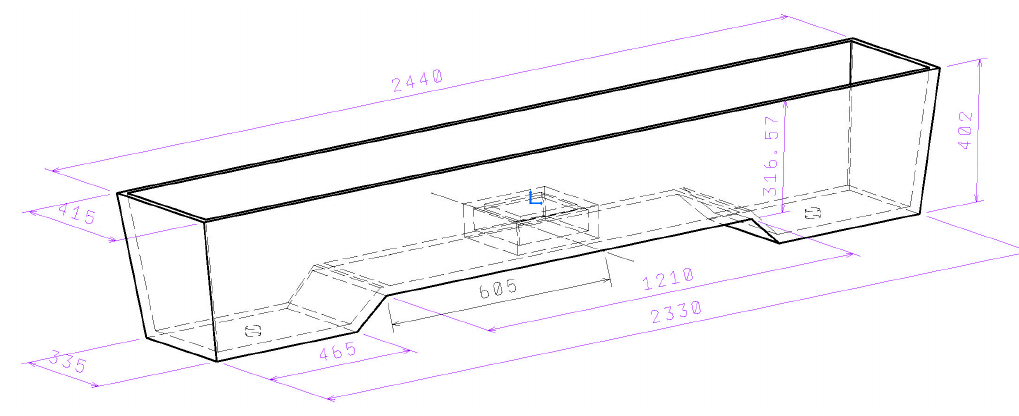
Figure 3. Position of the standard impact pad.